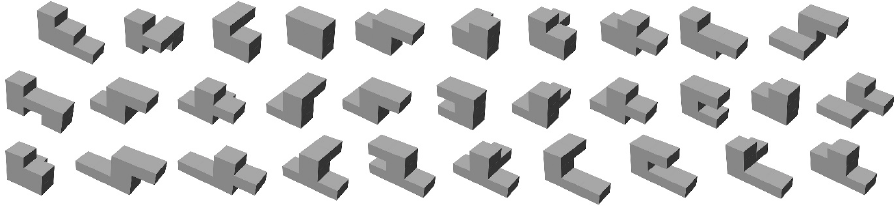
Figure 12. The generated 3-level batches (31 building shapes).